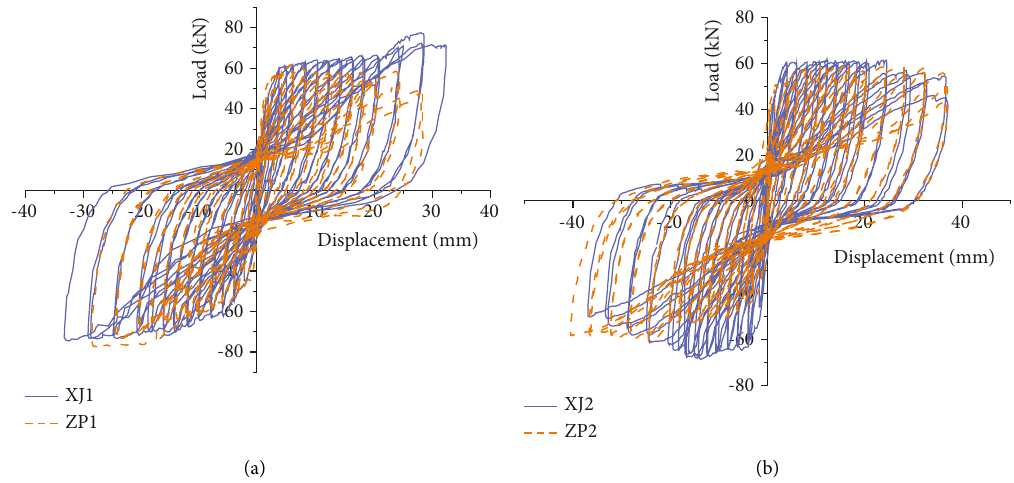
Figure 6: Hysteresis curve of specimen. (a) Hysteresis curves of XJ1 and ZP1. (b) Hysteresis curves of XJ2 and ZP2.